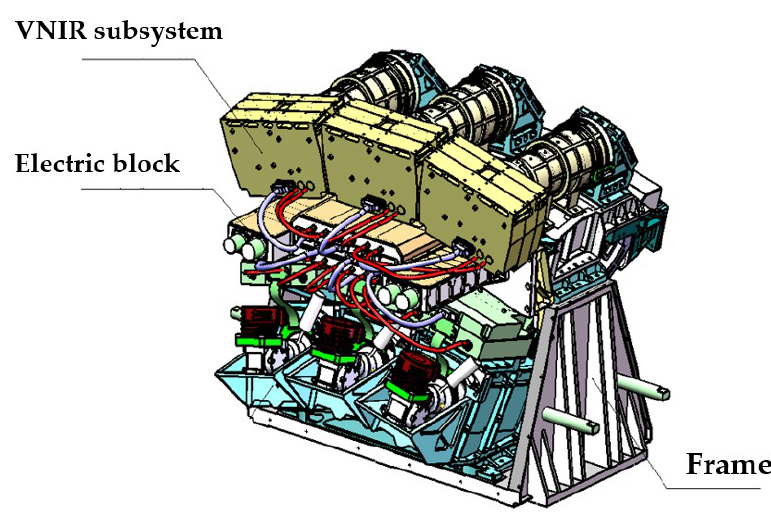
Figure 1. Sketch map of the Wide Swath and High Resolution Airborne Pushbroom Hyperspectral Imager (WiSHiRaPHI) system.